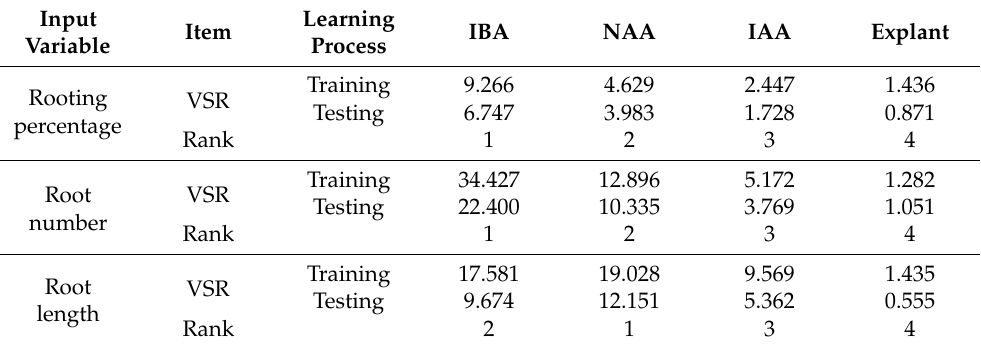
Table 3. Determining the importance of factors involved in in vitro rooting of P. caerulea through sensitivity analysis.